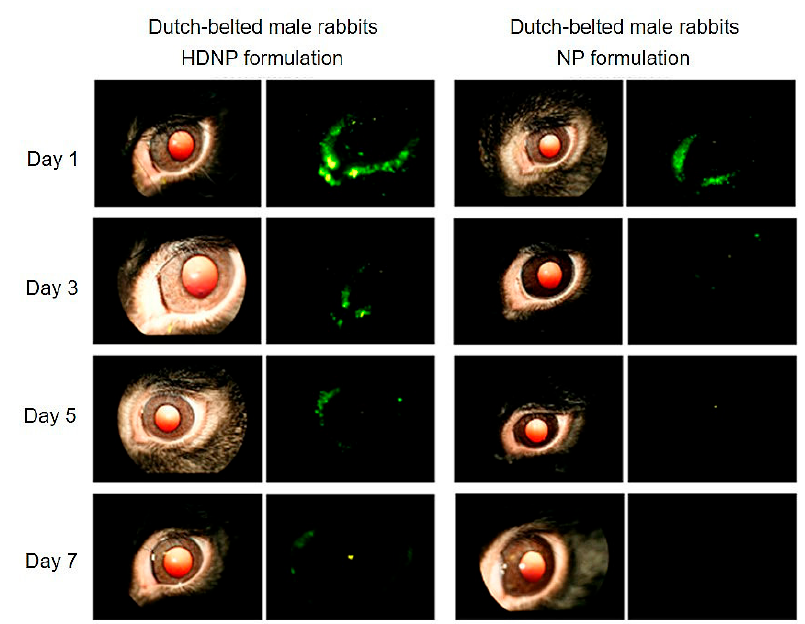
Figure 6. Fundus camera acquisitions of rabbits’ eyes after hybrid polyamidoamine (PAMAM) dendrimer hydrogel / poly(lacticco-glycolic acid) (PLGA) nanoparticle platform (HDNP) and NP Formulations (NP) topical administration FluoSpheres were confined in nanosistems to follow the distribution and retention in the eye. The analysis was performed at the end of 1, 3, 5, and 7 days of formulations instillation. Left: regular fundus camera images of the eyes; right: fluorescent fundus camera images. Adapted with permission from [150], copyright (2012), American Chemical